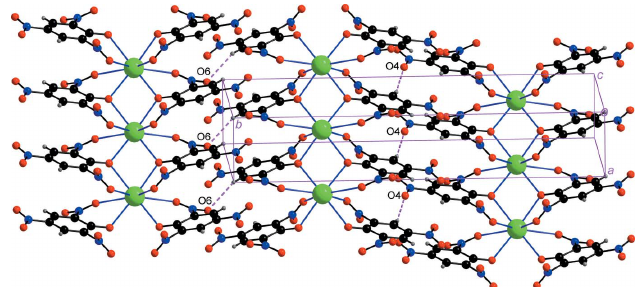
Figure 5 Interchain C—H (cid:2)(cid:2)(cid:2) O hydrogen bonds, shown as broken pink lines for